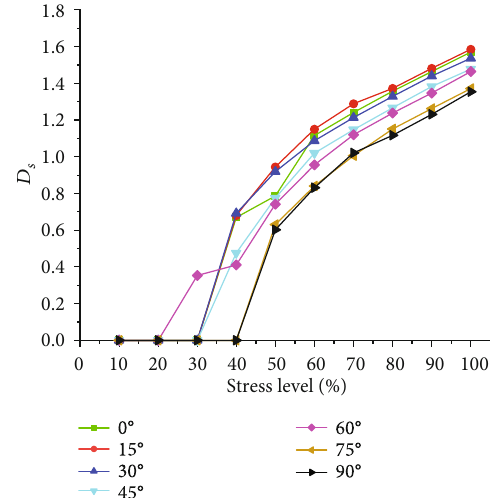
Figure 17: Relationship between stress levels and fractal dimensions at di ff erent azimuth angles.